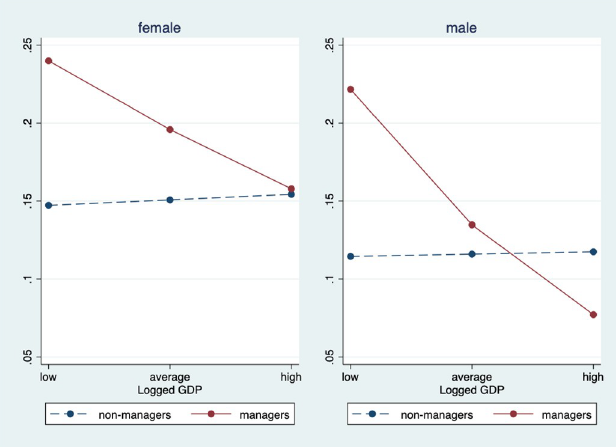
Fig 2. Predicted probability of restless sleep by logged per capita GDP (based on Model